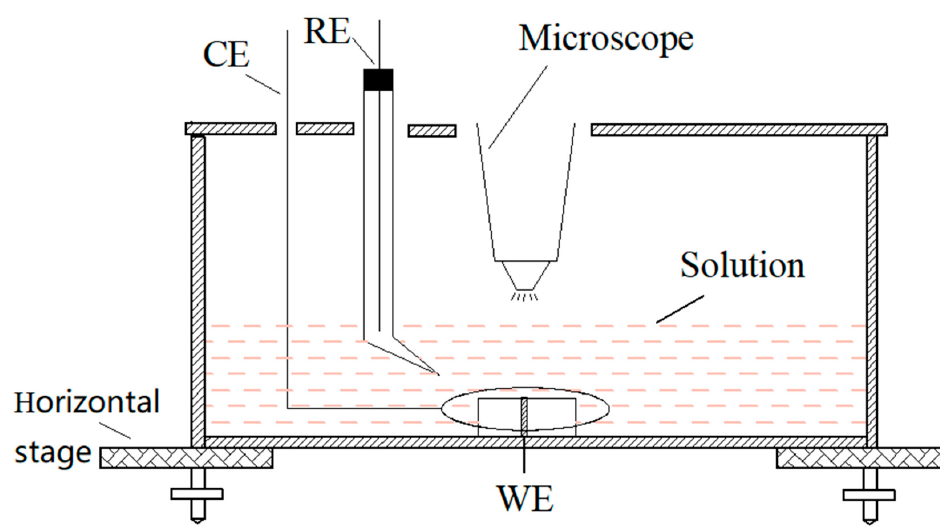
Figure 1. The schematic of chromogenic testing device.